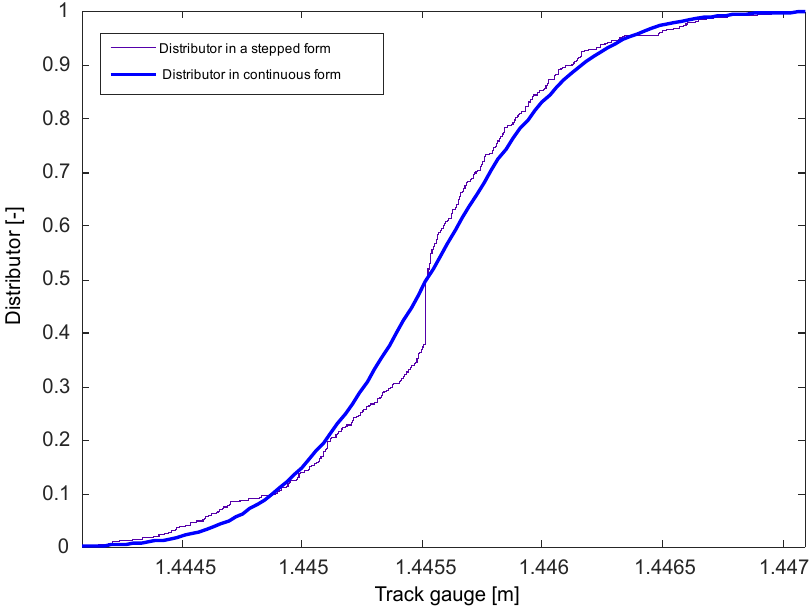
Figure 7. Track gauge distribution function in a rail turnout.